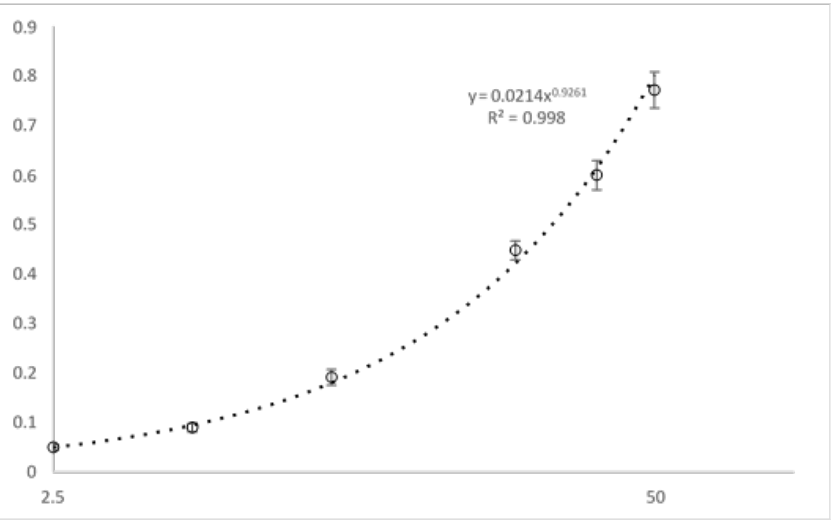
Figure 6. Analysis of 70 patient samples with LC-MS/HRMS and ELISA. Passing–Bablok regression (left) and Bland-Altman (right) analysis between the LC-MS/HRMS method and the ELISA method. For Passing–Bablok analysis, the solid and dashed lines indicate the regression line and confidence interval for the regression line, respectively. For Bland-Altman analysis, the solid line indicates the mean difference between the methods.